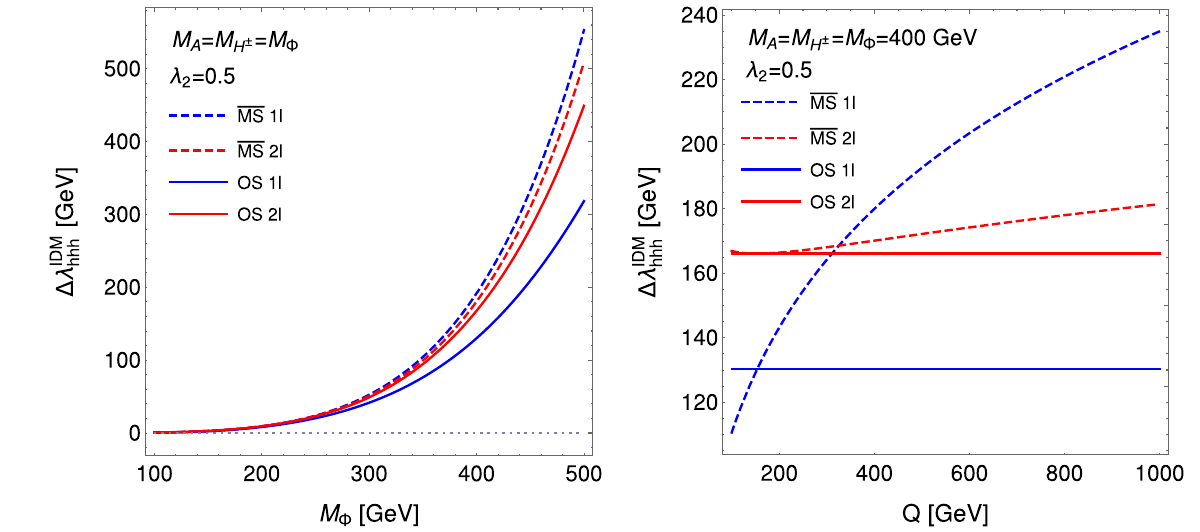
≡ λ IDM − λ SM Secs. 3 and 5. ( Left side ): Δλ IDM as a function of the pole mass M Φ , hhh hhh hhh hhh for parameters points where M A = M H ± = M Φ and for λ 2 = 0 . 5. For the MS results, we fix Q = M Φ here. ( Right side ): Δλ IDM as a hhh function of the renormalisation scale Q , for the parameter point defined by M A = M H ± = M Φ = 400 GeV and λ 2 = 0 .